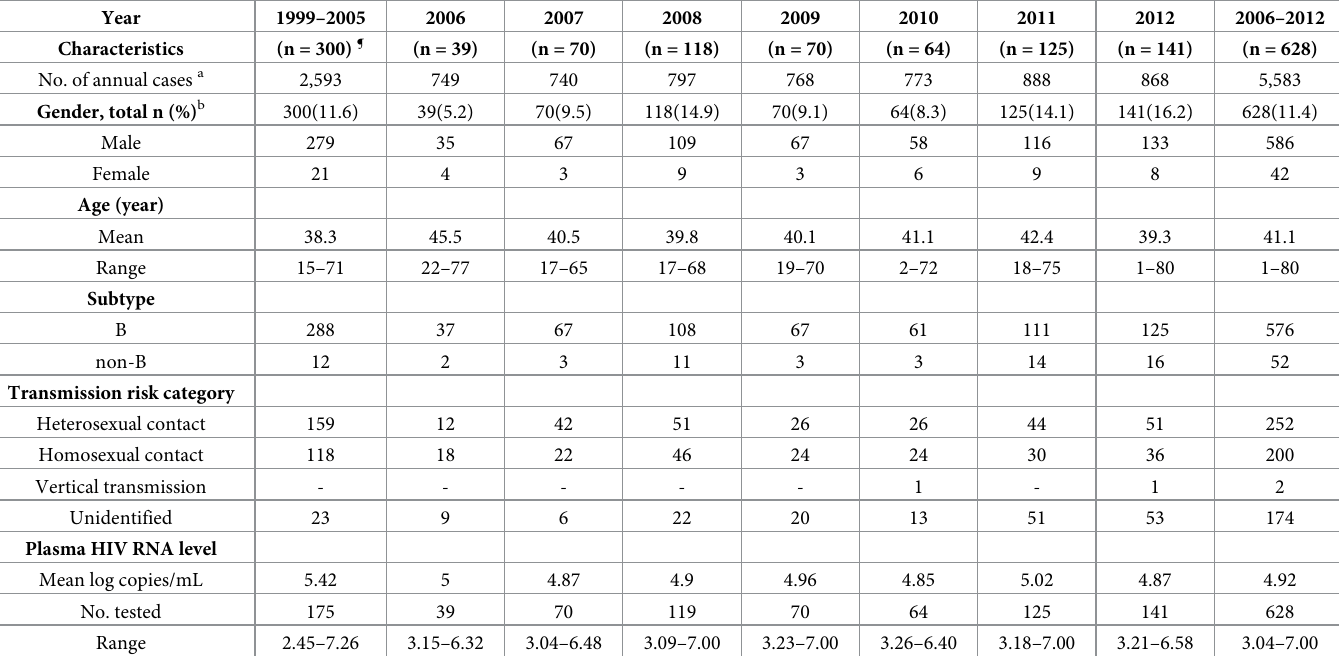
Table 1. Demographic characteristics of the Korean antiretroviral drug-na ï ve HIV-1-infected population from 1999 to 2012 (n =